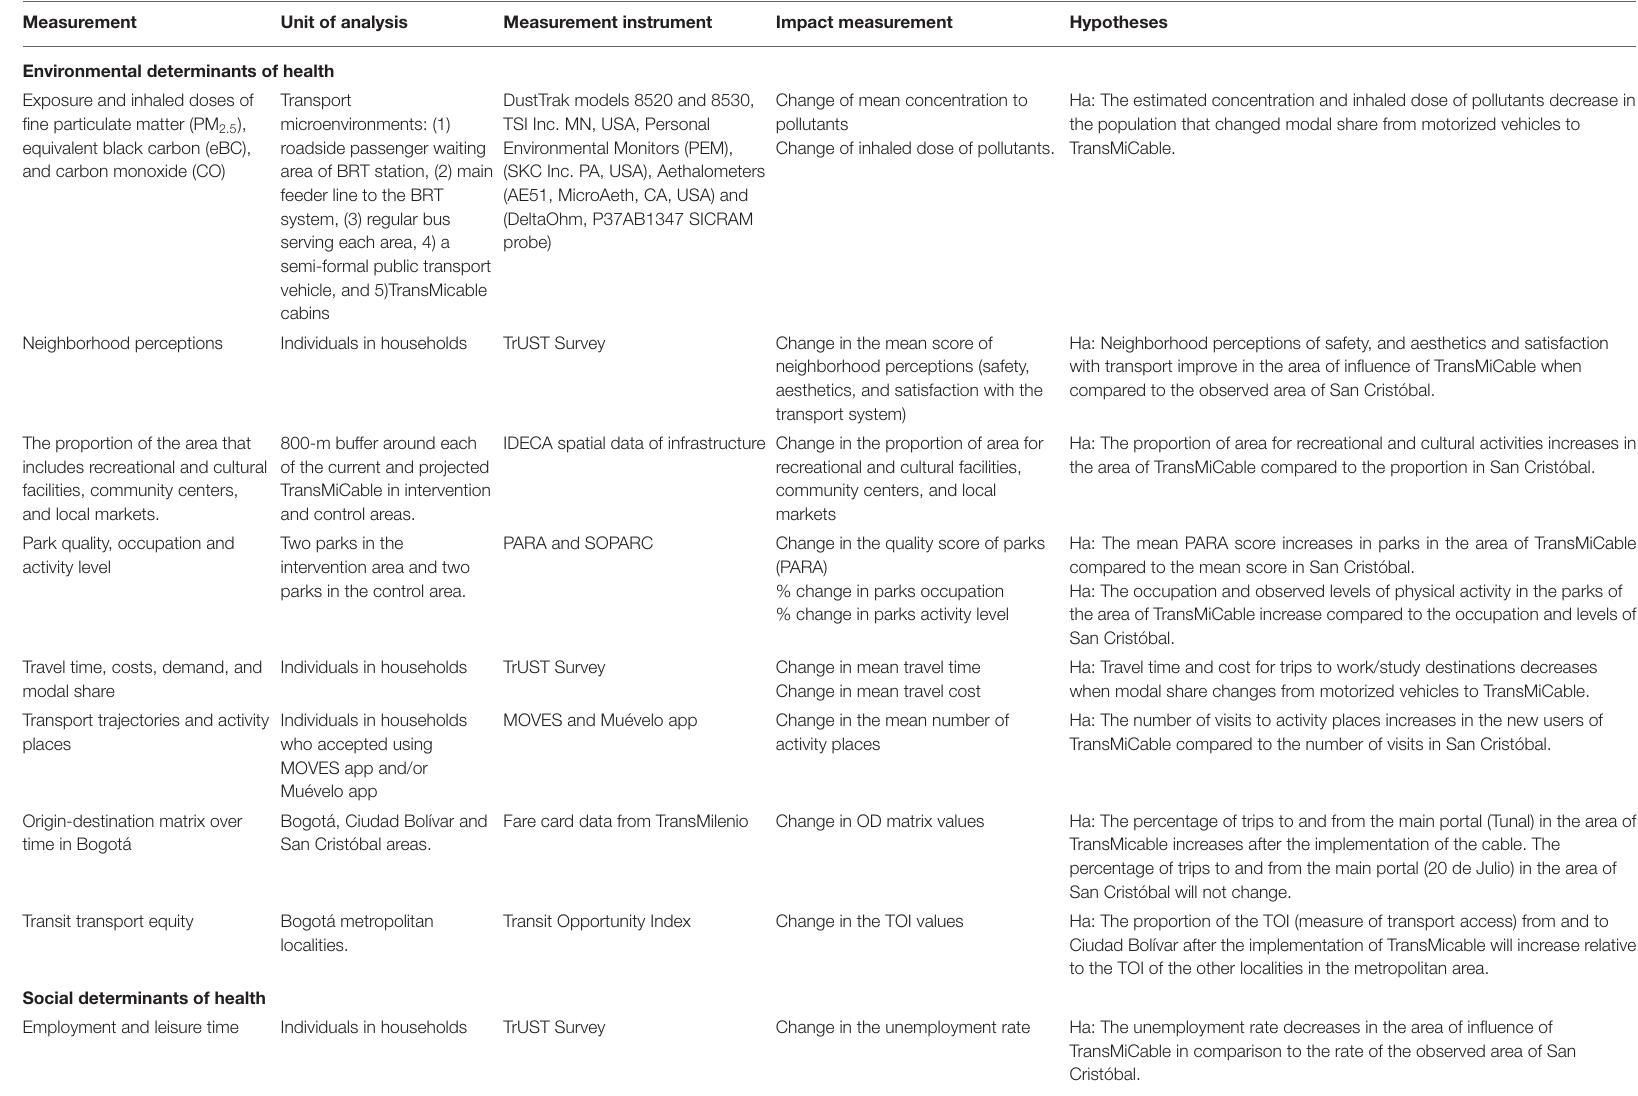
TABLE 1 | Measurements, unit of analysis of indicators, and hypotheses of the TrUST study.